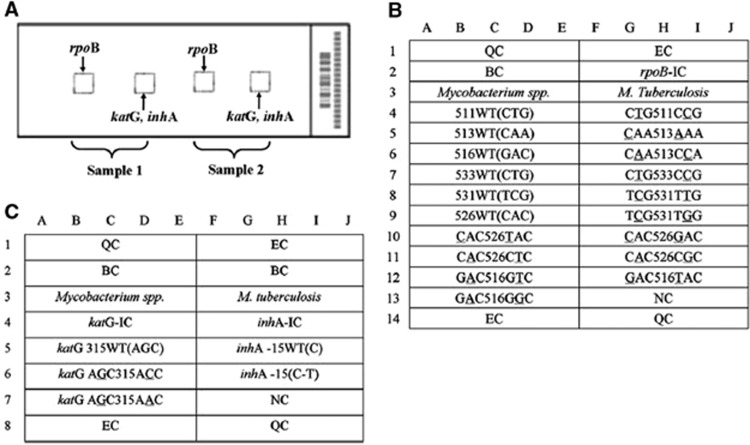
Schematic diagram of the DNA probe array for rpoB, katG and inhA detection. (A) The biochip contains two microarrays, and two specimens can be analyzed in parallel; in each array, one subarray is for RMP, and the other is for INH. (B) Six rpoB wild-type probes and thirteen mutation-type probes were designed for the detection of RMP resistance. (C) For the detection of INH resistance, one probe covers the wild-type codon 315 of katG and two mutation-type probes for the same region, and one wild-type probe and one mutation-type probe are used to detect the inhA promoter region. All probes were immobilized horizontally five times. QC, quality controls; EC, external controls; BC, blank controls; NC, negative controls; IC, internal controls; WT, wild type.